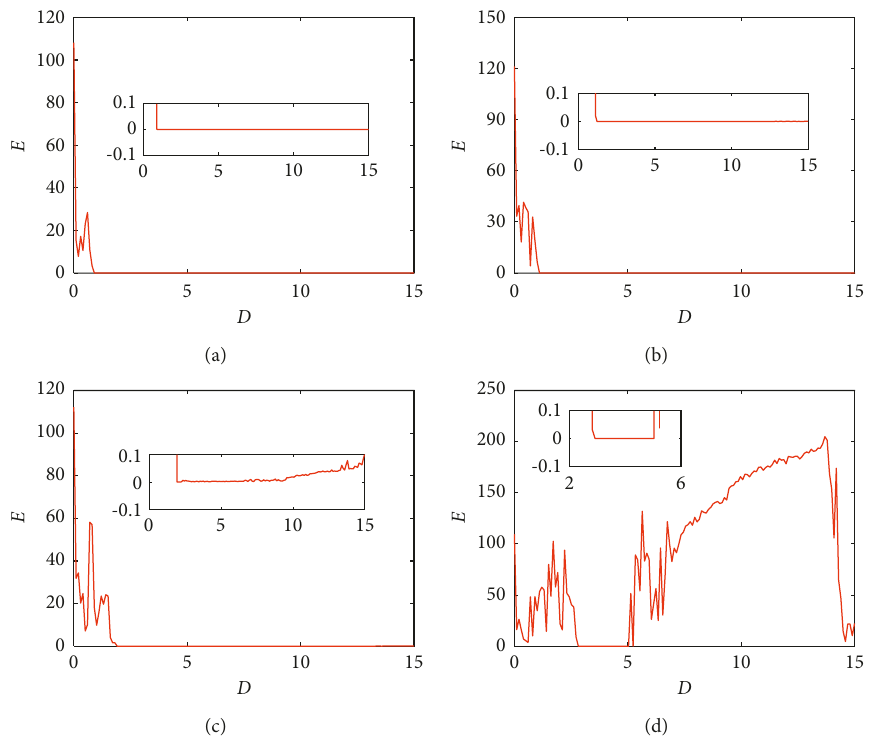
Figure 11: The synchronization errors of the coupled model with respect to coupling strength at case 3 (periodical and quiescent neurons). For (a) τ � 0 . 01; (b) τ � 0 . 1; (c) τ � 0 . 5; and (d). τ � 3. Partially enlarged interval for partial synchronization, and the initial values are selected with (0.1, 0.01, 1.05, 0.1, 0.01,